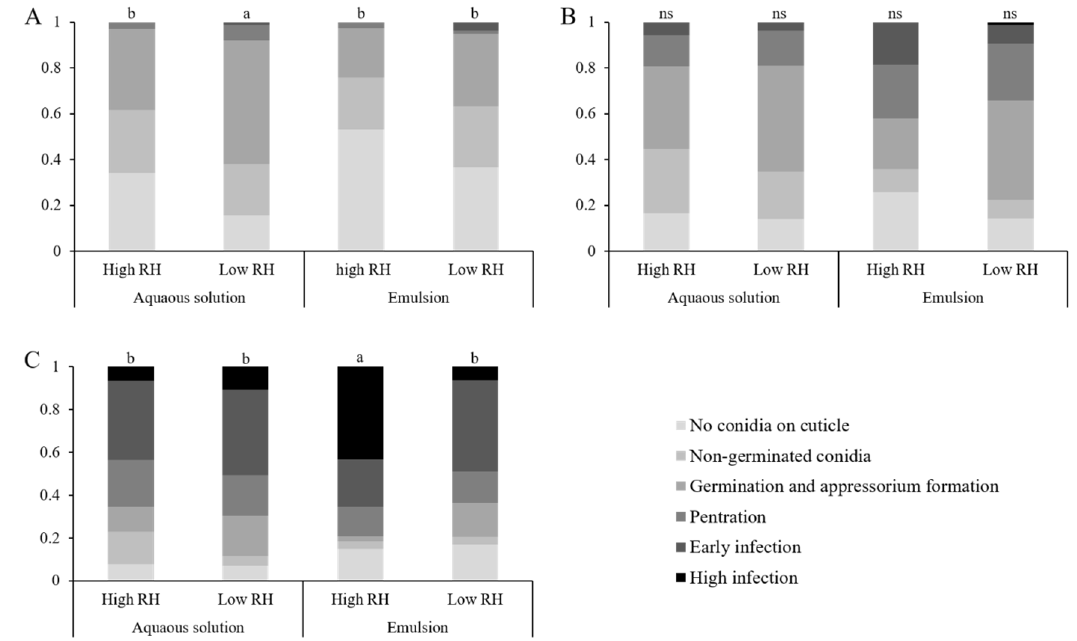
Figure 8. Distribution of disease stages amongst larval cohorts (for sample size see Table 1) over time. Larvae were exposed to leaves treated with aqueous solution or emulsion-formulated conidia at high or low RH. Larvae were sacrificed daily and examined under a confocal microscope. The disease stage of every larva was recorded and shown above as a percent of the total larvae examined: ( A ) one DPI ( B ) two DPI ( C ) three DPI. An each-pair Wilcoxon test was employed, different lower- case letters indicate a significant difference between treatments, ns indicates no significant difference between treatments. p -values were then subjected to a Holm–Bonferroni family-wise error rate (FWER) correction ( α <